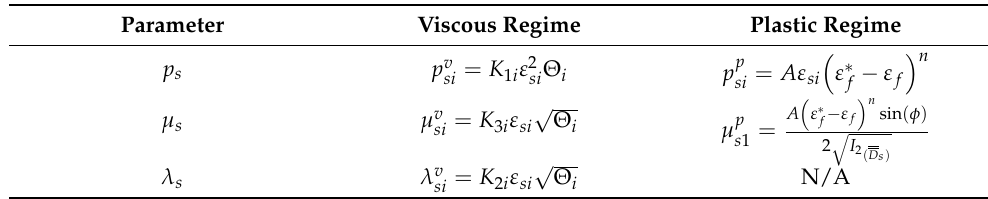
Table 1. The expressions for solid pressure, shear viscosity, and bulk viscosity of the solid phase after Jenike [31] and Schaeffer